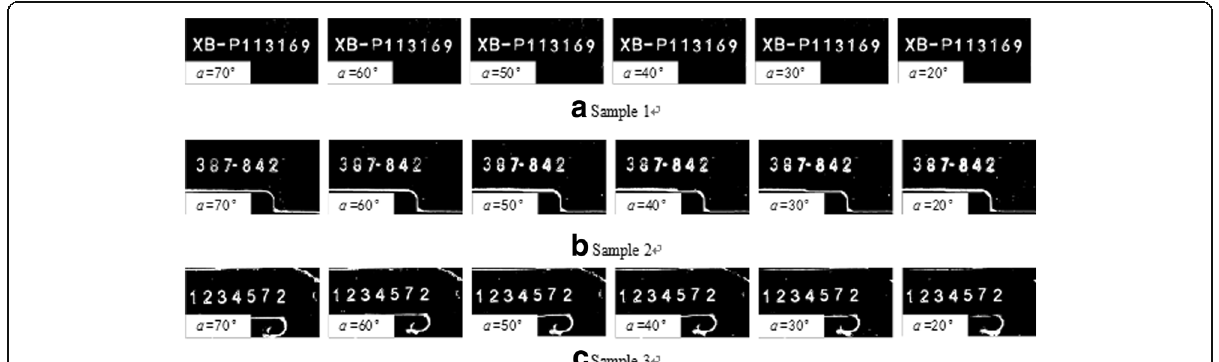
Fig. 9 a – c Image fusion results for different samples at different illumination directions